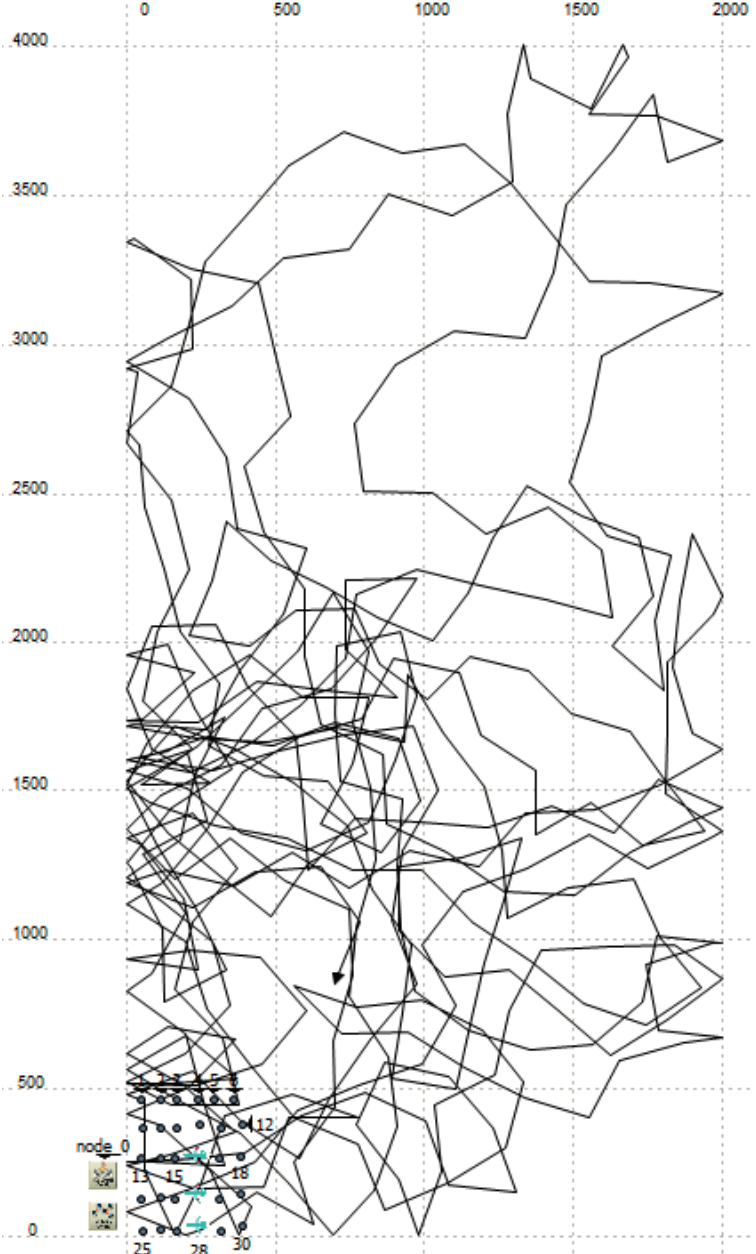
Figure 4. Trajectory of a UAV under the Gauss–Markov (GM)